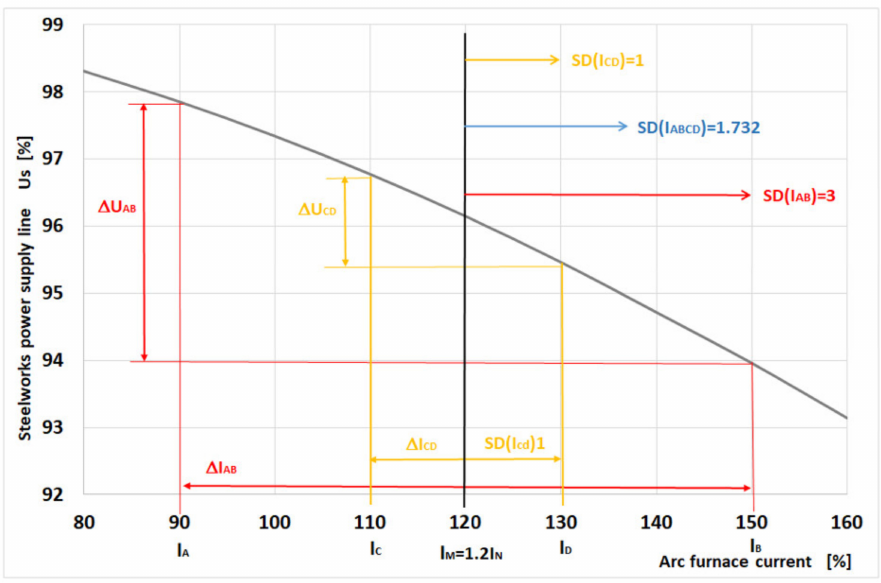
Figure 8. Voltage fluctuations for different histograms of arc furnace current